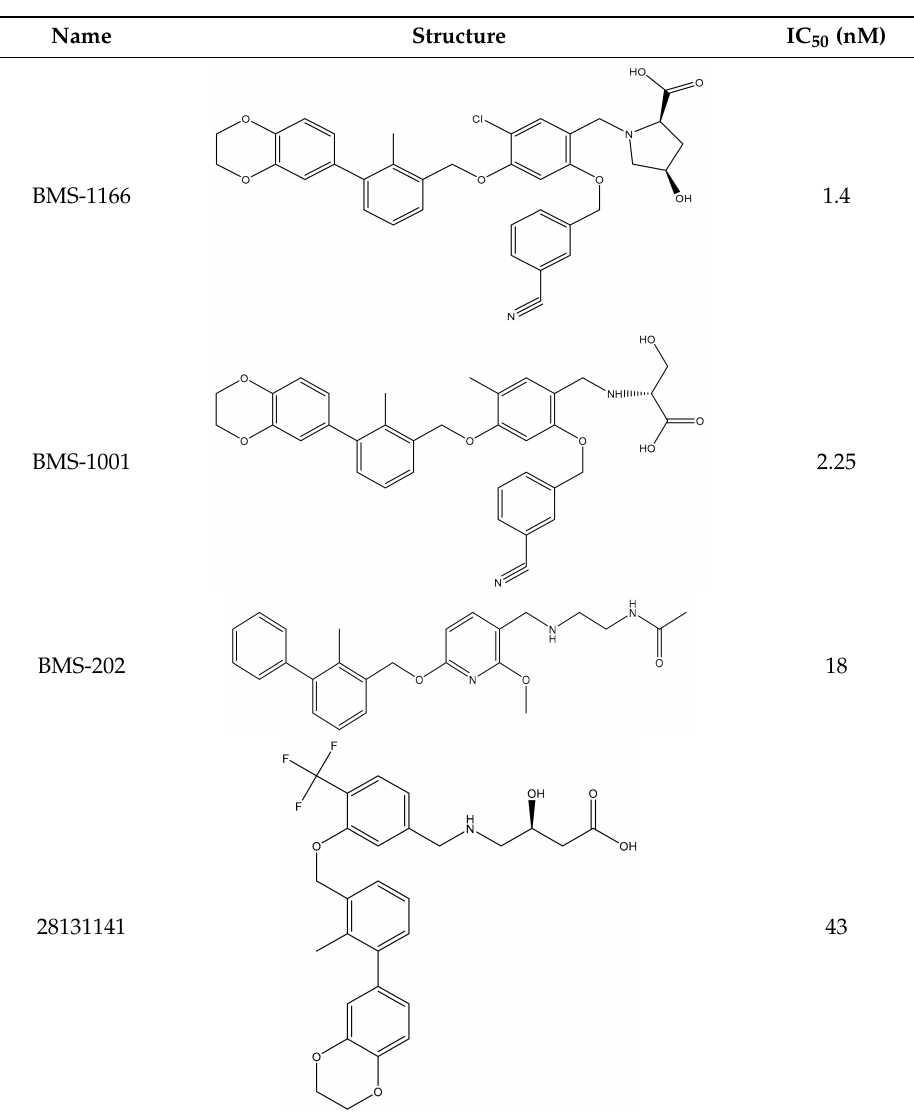
Table 5. Structures of compounds showing IC 50 values determined via the homogenous time-resolved fluorescence (HTRF) binding